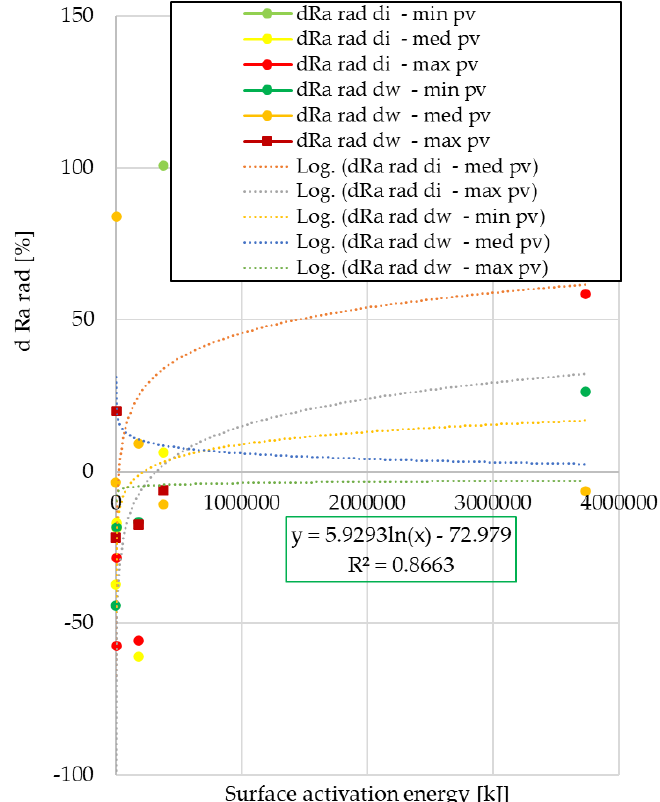
Figure 13. Variation of radial Ra values after pin-on-disk as a function of surface activation energy—clutch killer facings.